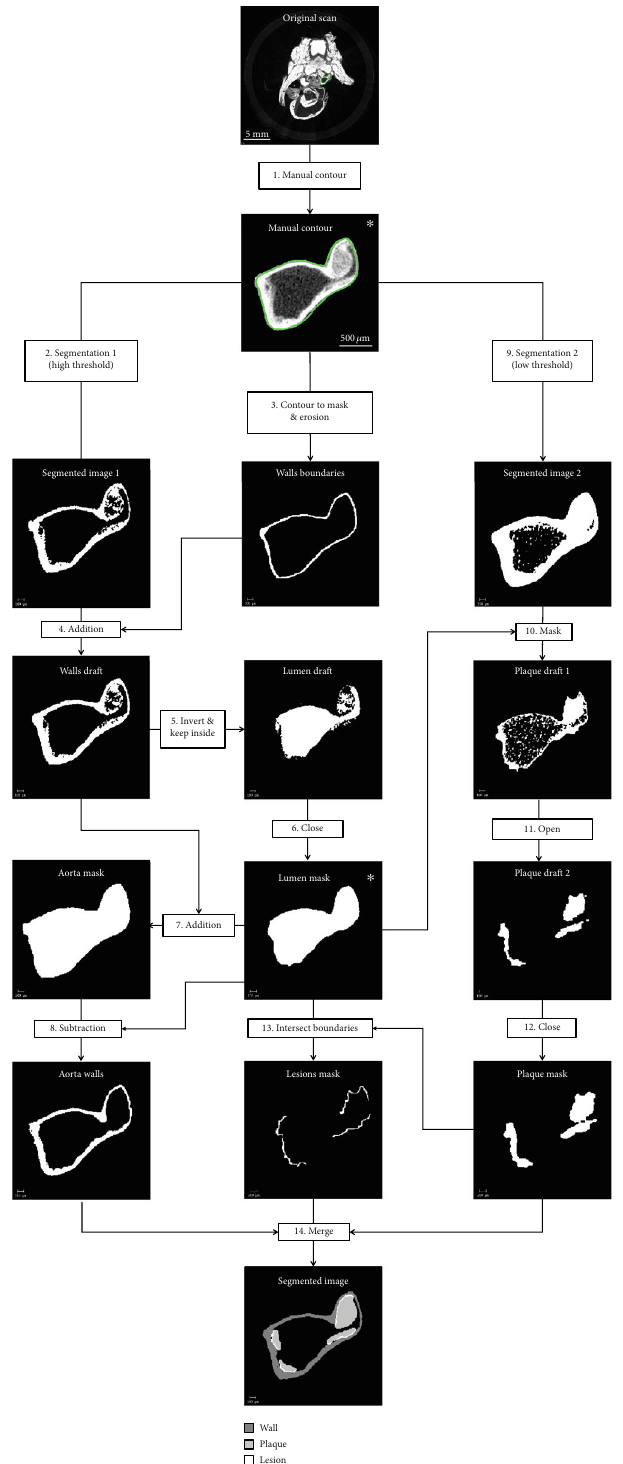
Figure 1: Representation of the segmentation algorithm. (a) Cropping to ROI. (b) High threshold to create aortic wall draft. (c) Manual contour converted into a mask. (d) Inward dilation by two voxels and juxtaposition to wall draft. (e) Inversion and inner volume extracted as lumen draft. (f) Dilation/erosion (5 voxels) to remove plaque from lumen draft. (g) Addition of lumen mask and wall draft. (h) Subtraction of lumen generates wall mask. (i) Plaque segmentation: Gaussian fi lter ( σ = 0 : 8 ; support = 1 ) then low threshold ( μ = 2 : 0 cm -1 ). (j) Lumen mask applied. (k) Re fi nement with opening ( d = 1voxel ; minimumvolume = 2 % total volume ) followed by (l) closing ( d = 3voxels ) fi lters. (m) Aortic lesions de fi ned as contacts between plaque and wall. (n) Aortic wall, plaque, and lesion concatenated. ∗ indicates manual